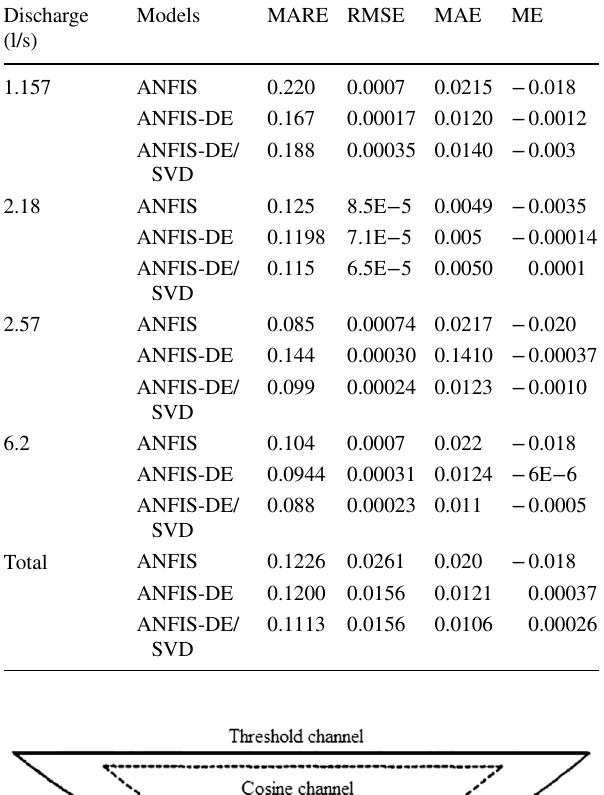
Table 3 Evaluation and comparison of the model ANFIS, ANFIS- DE and ANFIS-DE/SVD at different discharges and in total (average) using various statistical indices (test mode) Discharge (l/s)